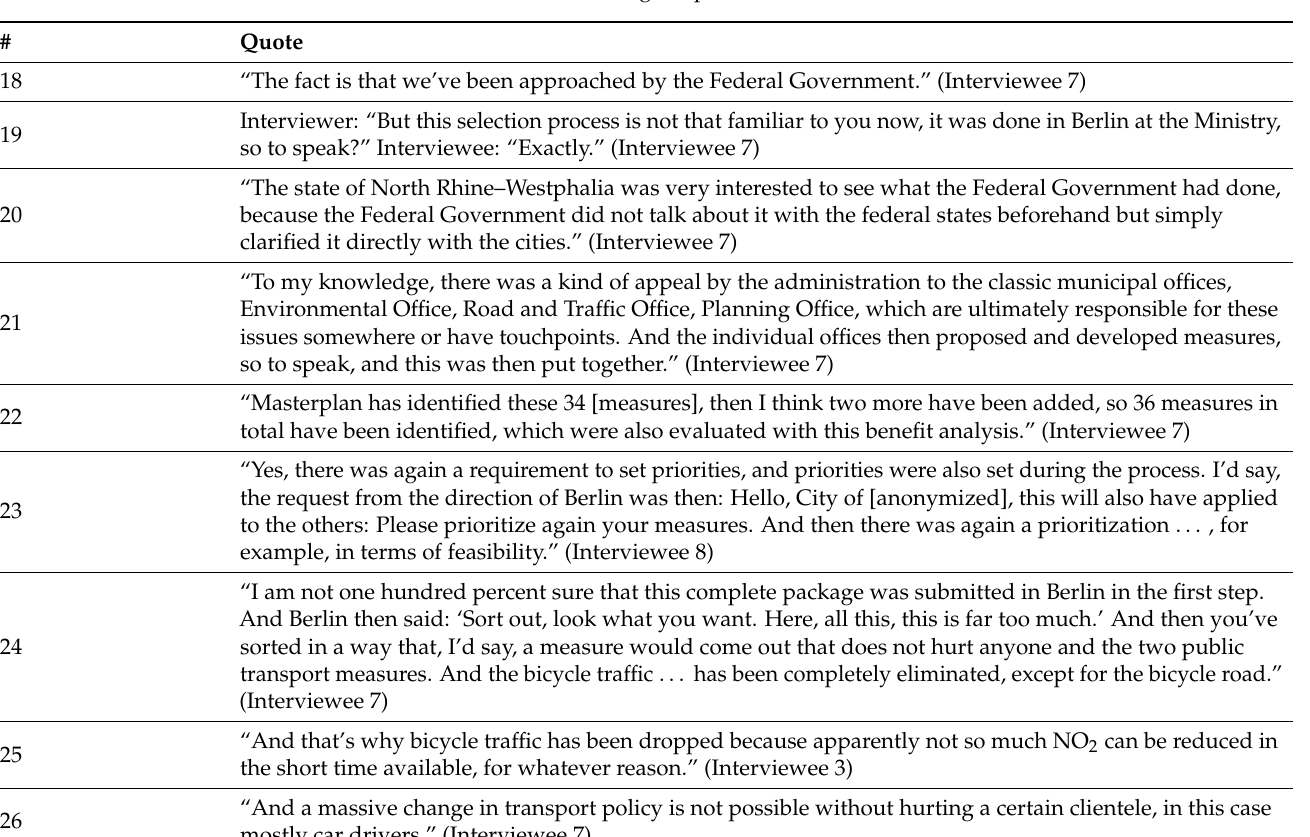
Table 7. Quotes from the interviews outlining the politics stream in the three Lead